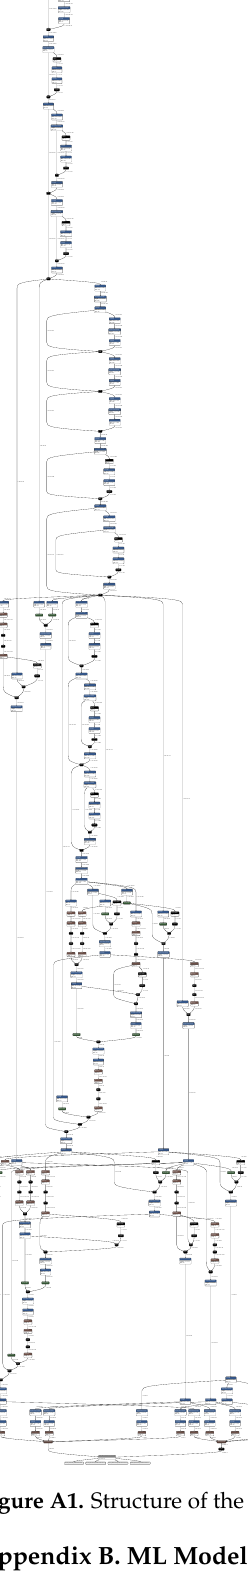
is presented in Figure